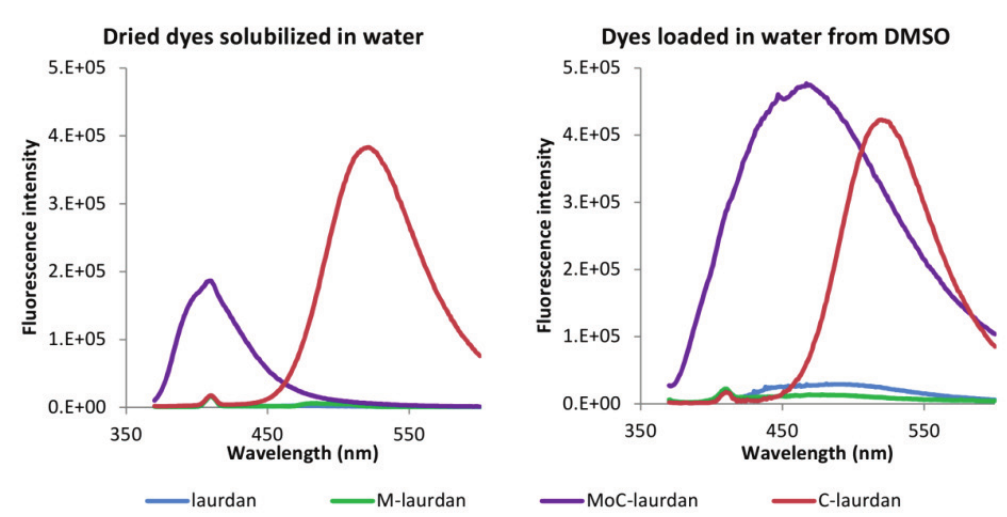
Supplemental Figure S3. Fluorescence emission in water. Left panel: For all four dyes, the volumes of chloroform stock solutions corresponding to 3 nanomoles were dried in test tubes under nitrogen, followed by further evaporation with a vacuum pump for 2 hours. Water (3 ml) was added to each sample (final theoretical concentration: 1 µM), which were vortexed for 30 seconds at room temperature and emission spectra were then measured with a FLSP920 (Edinburgh Instruments, Scotland) fluorimeter with excitation set to 360 nm. Right panel: Dyes were dissolved in DMSO to obtain stock solutions of 1 mM. 3 microliters from those DMSO stock solutions were injected in 3 ml of water (final concentration of 1 µM). Emission spectra were then measured with a FLSP920 (Edinburgh Instruments, Scotland) fluorimeter. The very small peak at 410 nm corresponds to the Raman of water, as a consequence of the excitation set to 360